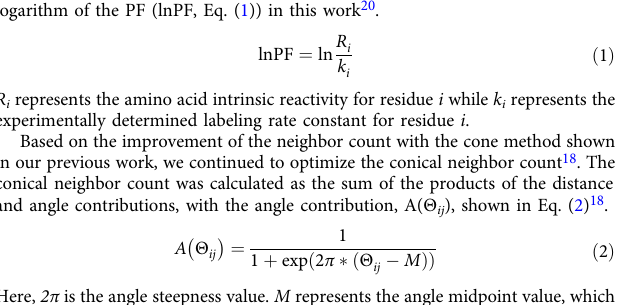
ffiffiffiffiffiffiffiffiffiffiffiffiffiffiffiffiP n i ¼ 1 diff